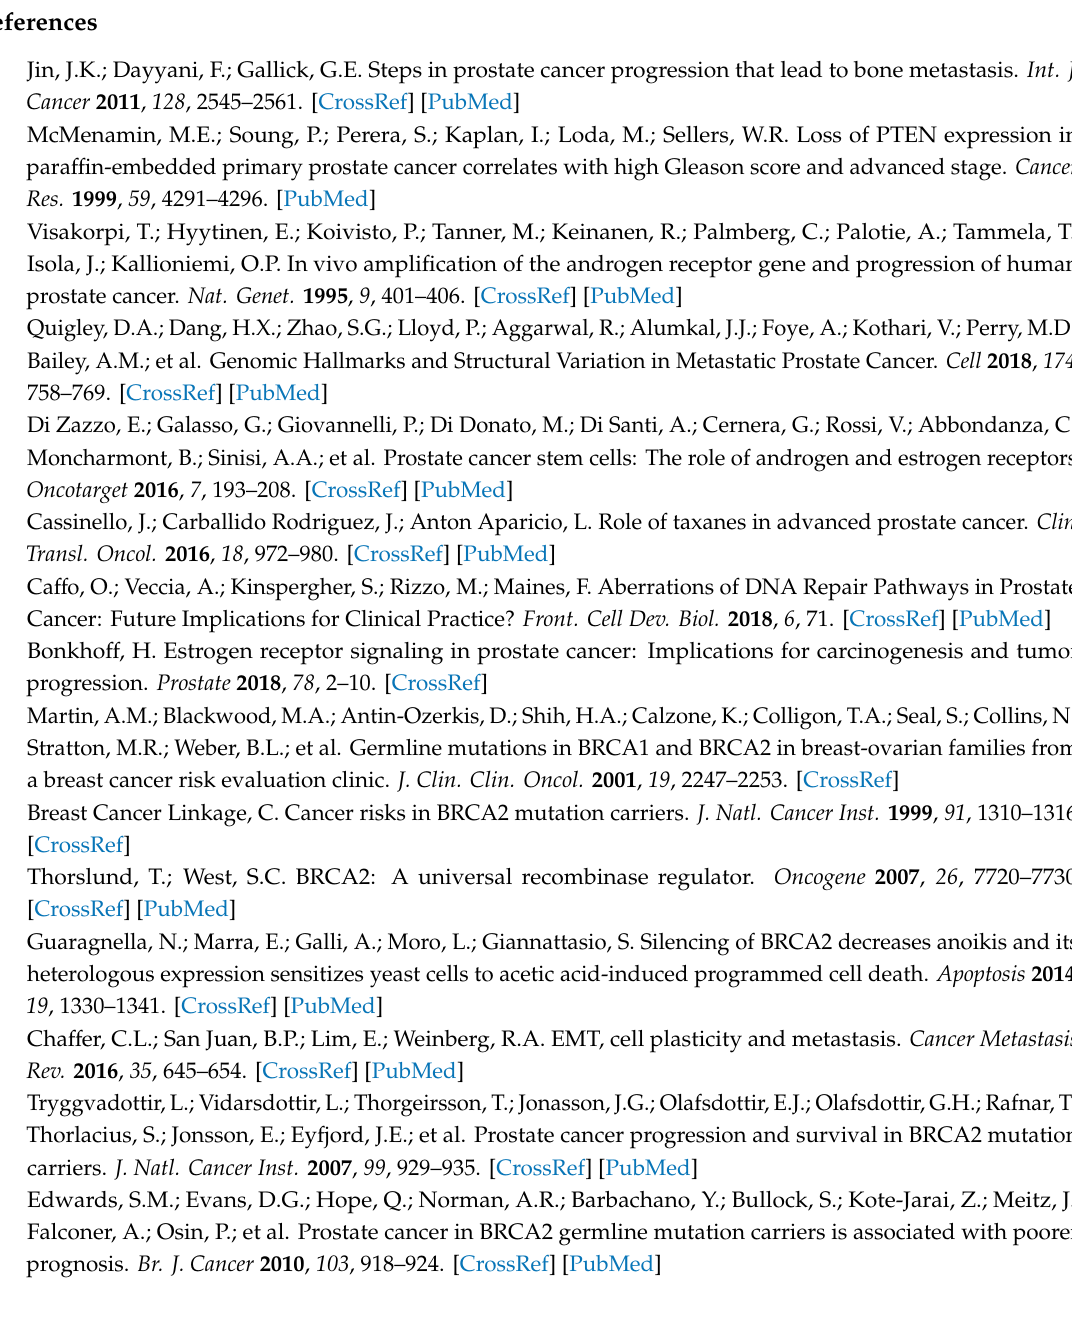
Figure S1: BRCA2 protein levels modulate the apoptotic cell response to 6-TG in prostate cancer